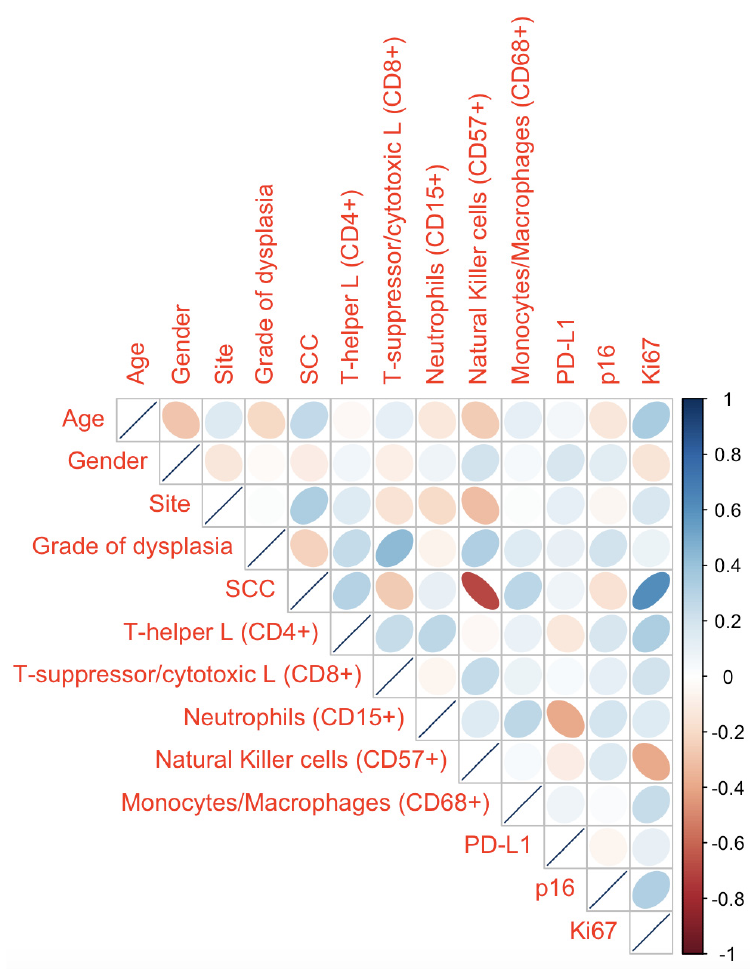
Figure 7. Correlation matrix between different clinical and pathologic variables. Each ellipse in the table represents a correlation between the two variables. The diagonal indicates that each variable perfectly correlates with itself. L is for lymphocytes.